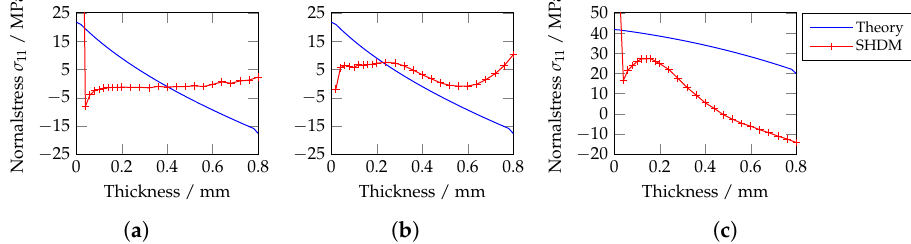
Figure 11. Comparison of the theoretical residual stress and the predicted residual stress state using the simulated hole drilling method for the out-of-plane waviness “Sinus D2”. The comparison is done at the three characteristic positions (Figure 8). It can be clearly observed that the induced fiber imperfection lead to recognizable deviations. ( a ) Pos. 1; ( b ) Pos. 2; ( c ) Pos. 3.